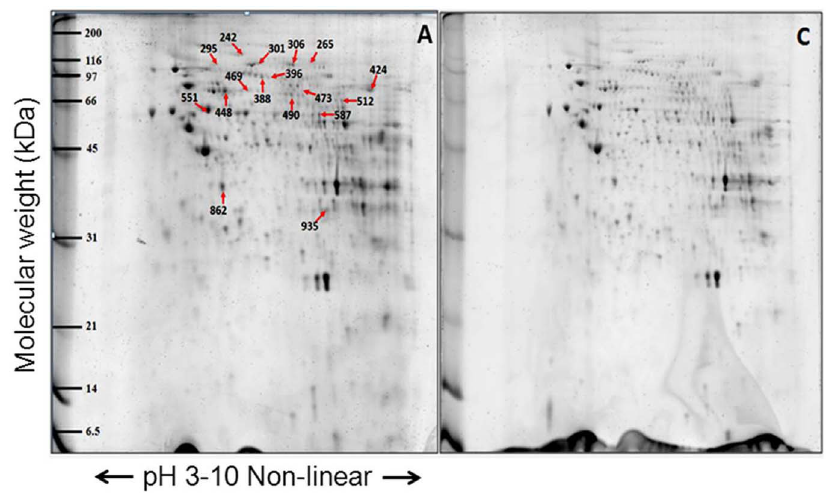
Figure 3. Representative proteome map of differentially expressed proteins from the mitochondrial fractions of fibroblasts from (A) LHON cases (n=7) and (C) controls (n=5). Equal amounts of proteins (100 m g) from each fibroblast sample were resolved by 2-DE. The numbers indicate the spot IDs of proteins whose expression levels differ significantly between the fibroblasts of LHON cases and controls.